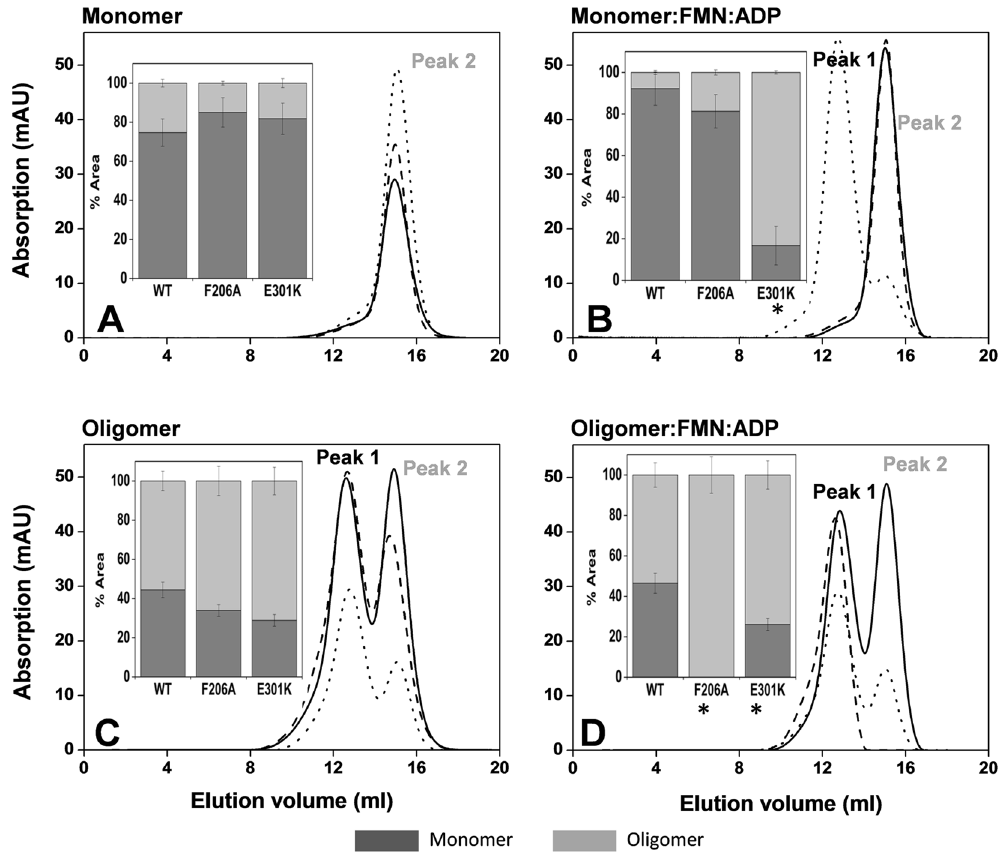
Figure 2. Gel filtration elution profiles of monomeric and oligomeric samples of WT (solid line), F206A (dashed line) and E301K (dotted line) Ca FADSs after incubation under different conditions. ( A ) The peak corresponding to the monomeric form, which was used as a control. ( B ) The peak corresponding to the monomeric form, after incubation with 25 μ M FMN and 200 μ M ADP. ( C ) The band corresponding to the oligomeric forms, which was also used as a control. (D) The band corresponding to the oligomeric forms, after incubation with 25 μ M FMN and 200 μ M ADP. The insets show the percentage of monomer (represented by the peak labelled peak 2) and the bulk of oligomeric species (labelled as peak 1) obtained from the chromatograms, with * indicating values that show statistically significant differences from the WT, as determined by the one- way ANOVA test ( P < 0.002; n = 3, confidence interval 95%). All samples contained 15–20 µ M of protein, 20 mM PIPES, 0.8 mM MgCl 2 , pH 7.0, and were incubated 10 min at room temperature before passing through a Superdex ™ 200 10/300 GL column in the same